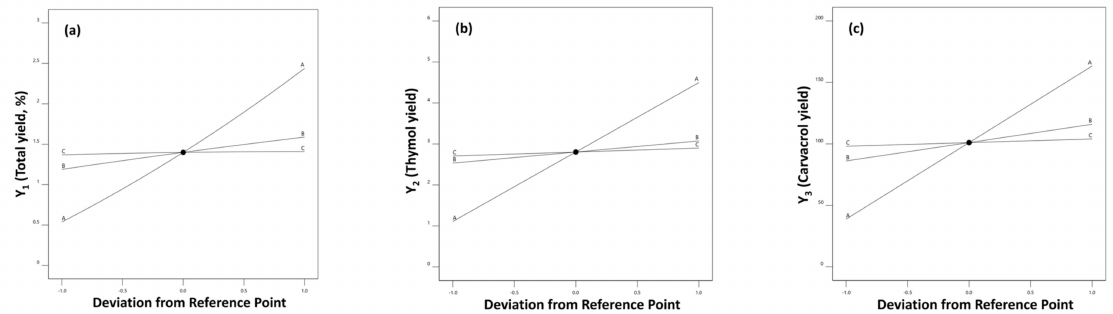
Figure 3. FCC perturbation plots for: ( a ) Y 1 (total yield); ( b ) Y 2 (thymol yield); ( c ) Y 3 (carvacrol yield) responses. Factor A corresponds to time (min), factor B corresponds to pressure (bar) and factor C corresponds to temperature ( ◦ C).